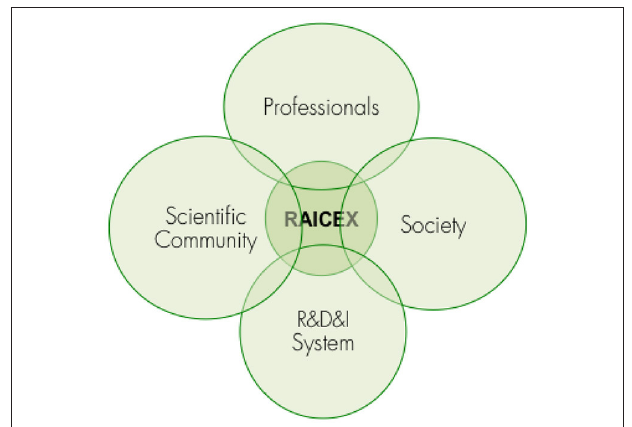
FIGURE 1 | The impact of RAICEX’s activities and